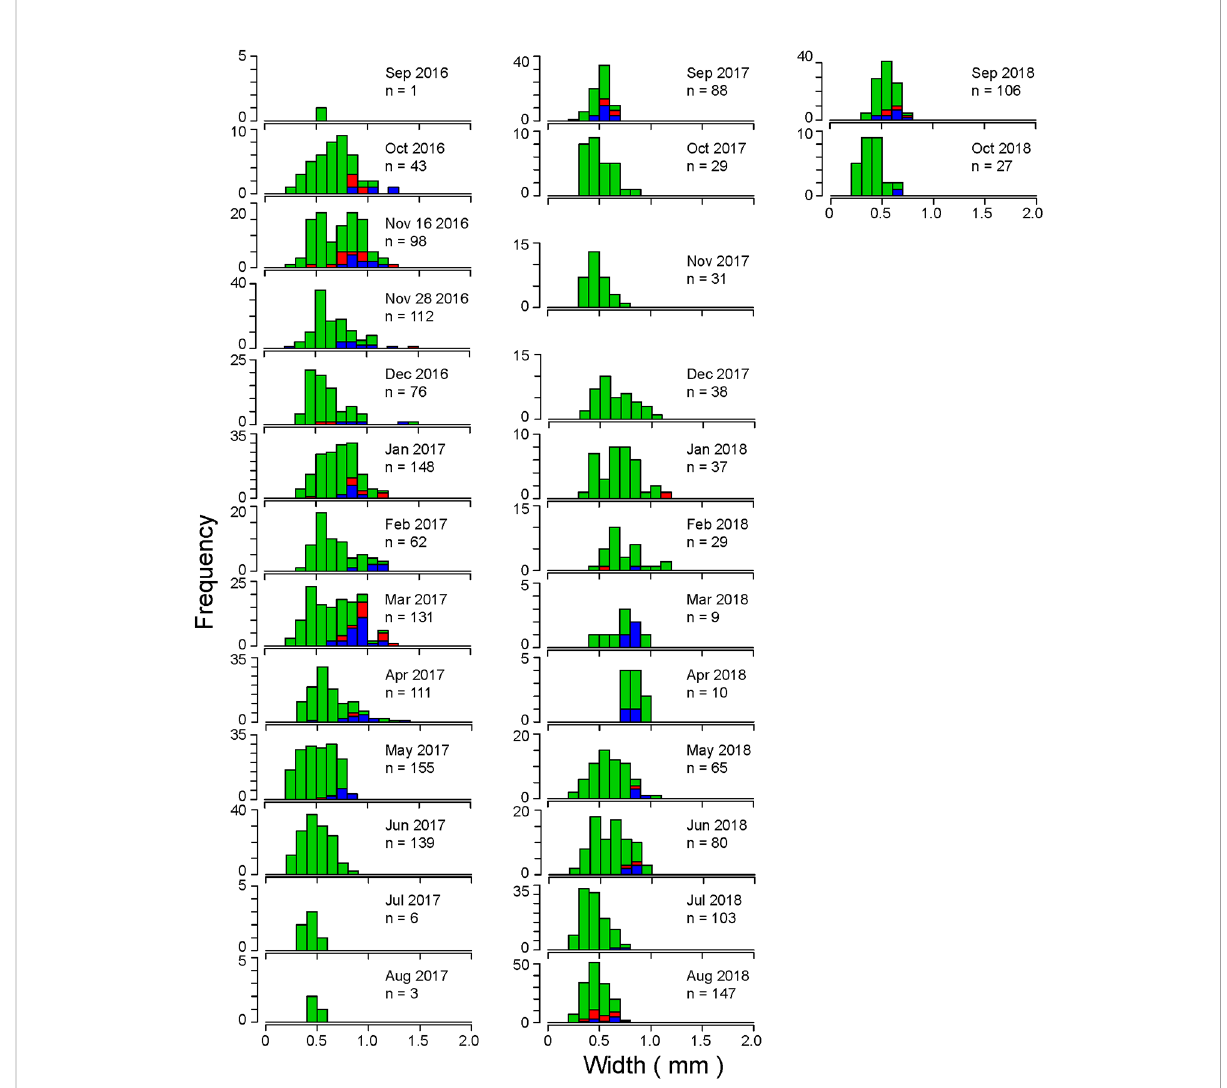
FIGURE 7 Size frequency distributions of the maximum width of the thoracic segment of C. aff. teleta at Stn D in Gamo Lagoon from September 2016 to October 2018. Red: females, blue: males, green: immature